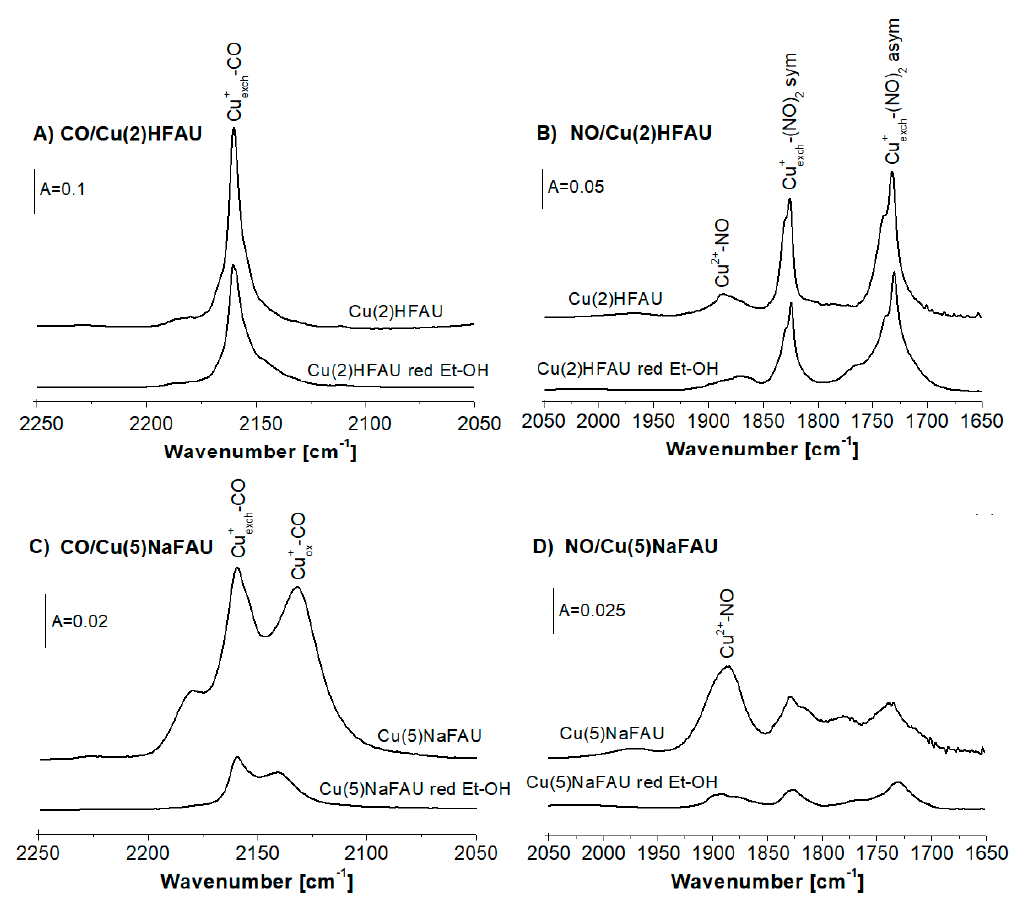
Figure 5. The IR spectra of CO sorbed at room temperature ( A ), NO sorbed at 190K ( B ) on the Cu2(H)FAU zeolite and the same sample reduced by ethanol. The IR spectra of CO sorbed at room temperature ( C ), NO sorbed at 190K ( D ) on the Cu(5)NaFAU zeolite and the same sample reduced by ethanol.